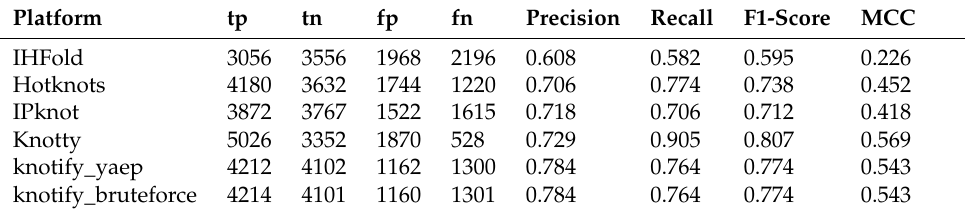
Table 5. Precision, recall, F1-score, and MCC per platform in entire dataset.